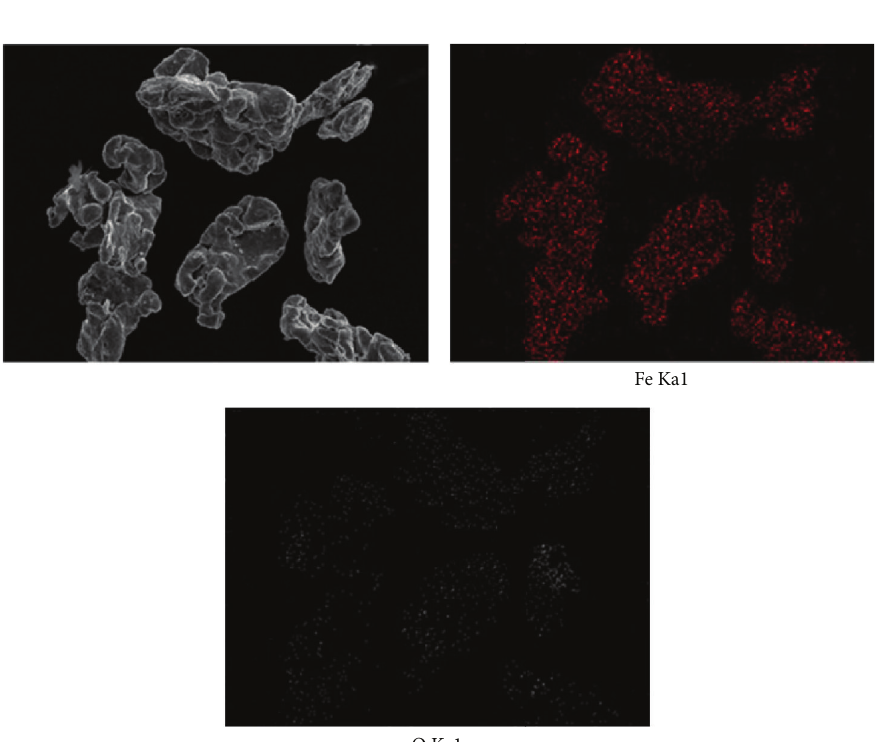
Figure 2: Element distribution on surface of passivated iron powders.